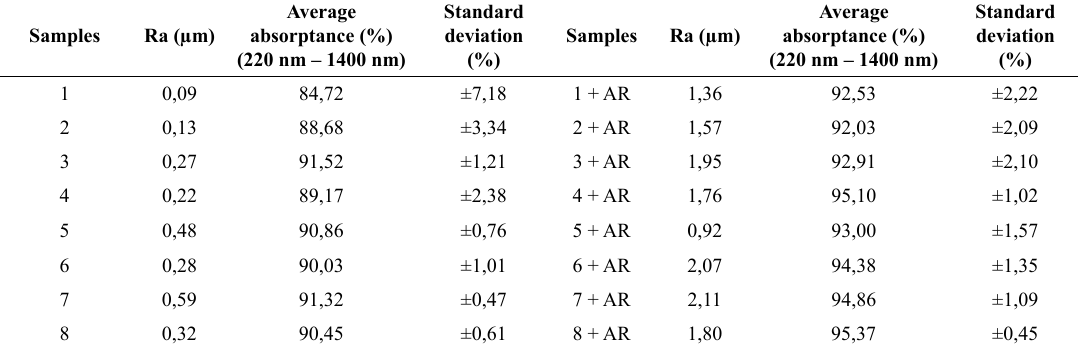
Table 3. Ra parameter of the electrodeposited films over copper substrate, with and without AR layer. Samples